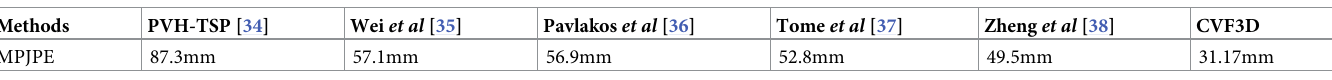
Table 4. The performance of CVF3D model (with Resnet-152) compared with other models in 3D pose estimation. The metrics (MPJPE) here is introduced in the experiment section of this article. This experiment uses the H36M dataset.